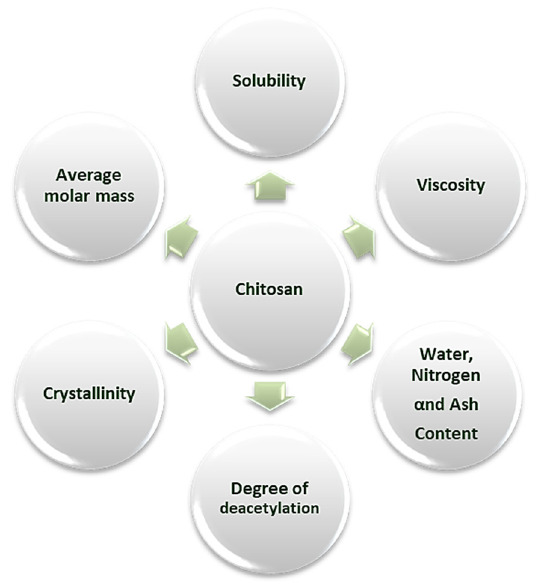
Figure 2. Physicochemical Properties of Chitosan.